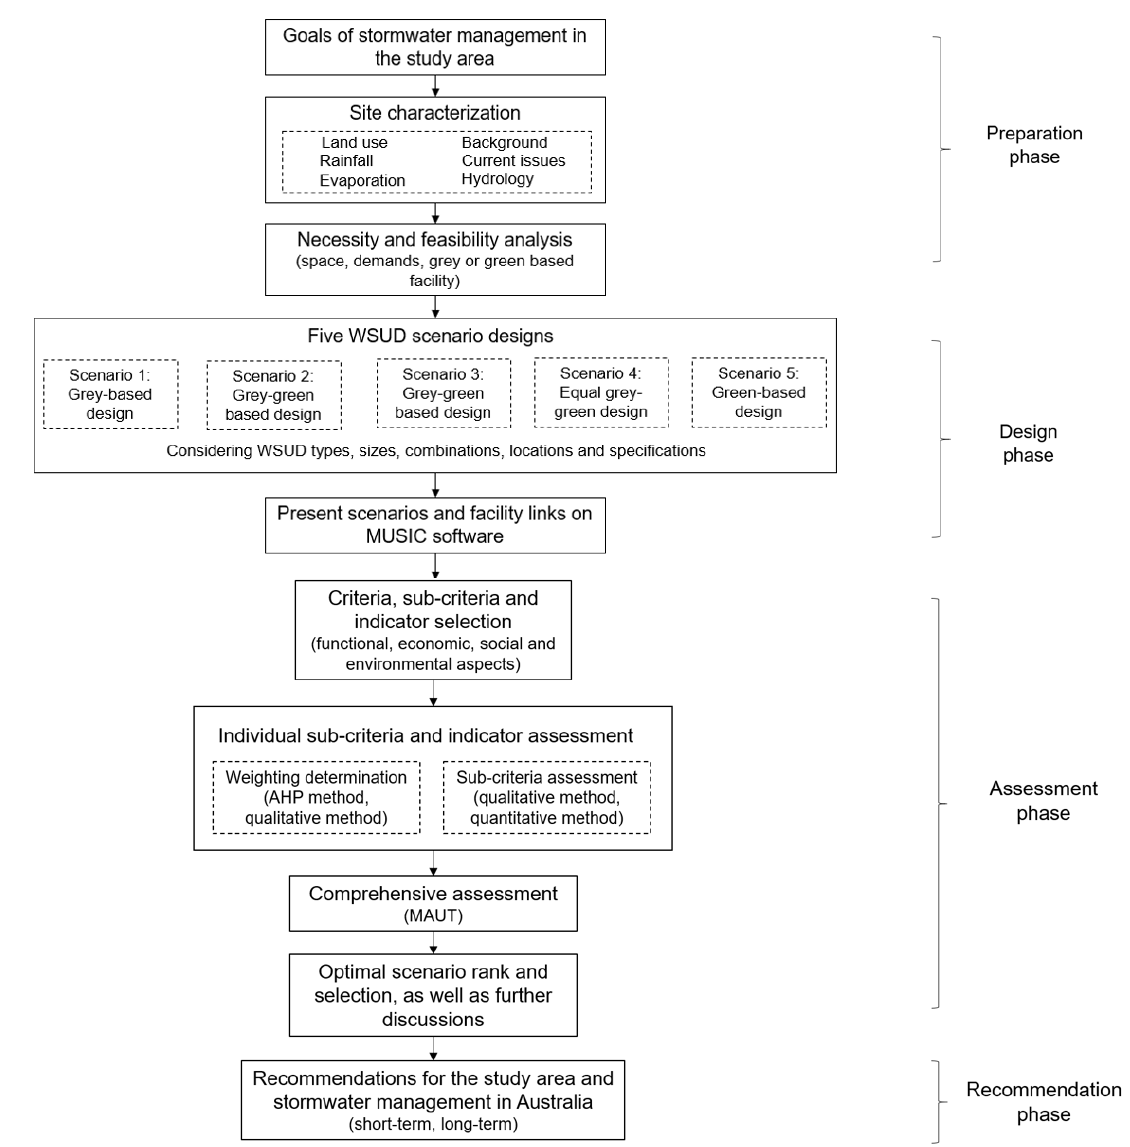
Figure 8. The framework of comprehensive assessment for five WSUD scenarios.